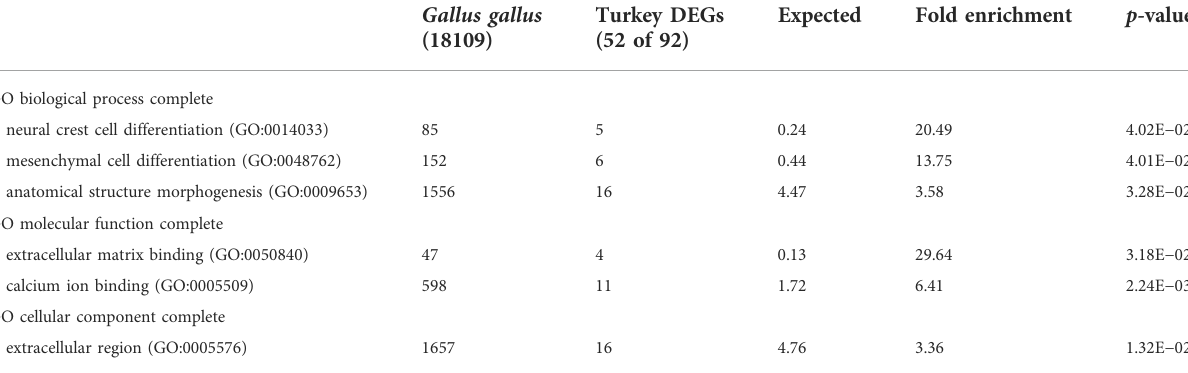
TABLE6PANTHEROverrepresentationtestof92DEGsdownregulatedintheNCTcellsrelativetotheRBC2at38 ° Cafter72 hofproliferation.Shown are the gene ontology categories with the greatest fold enrichment in each category a